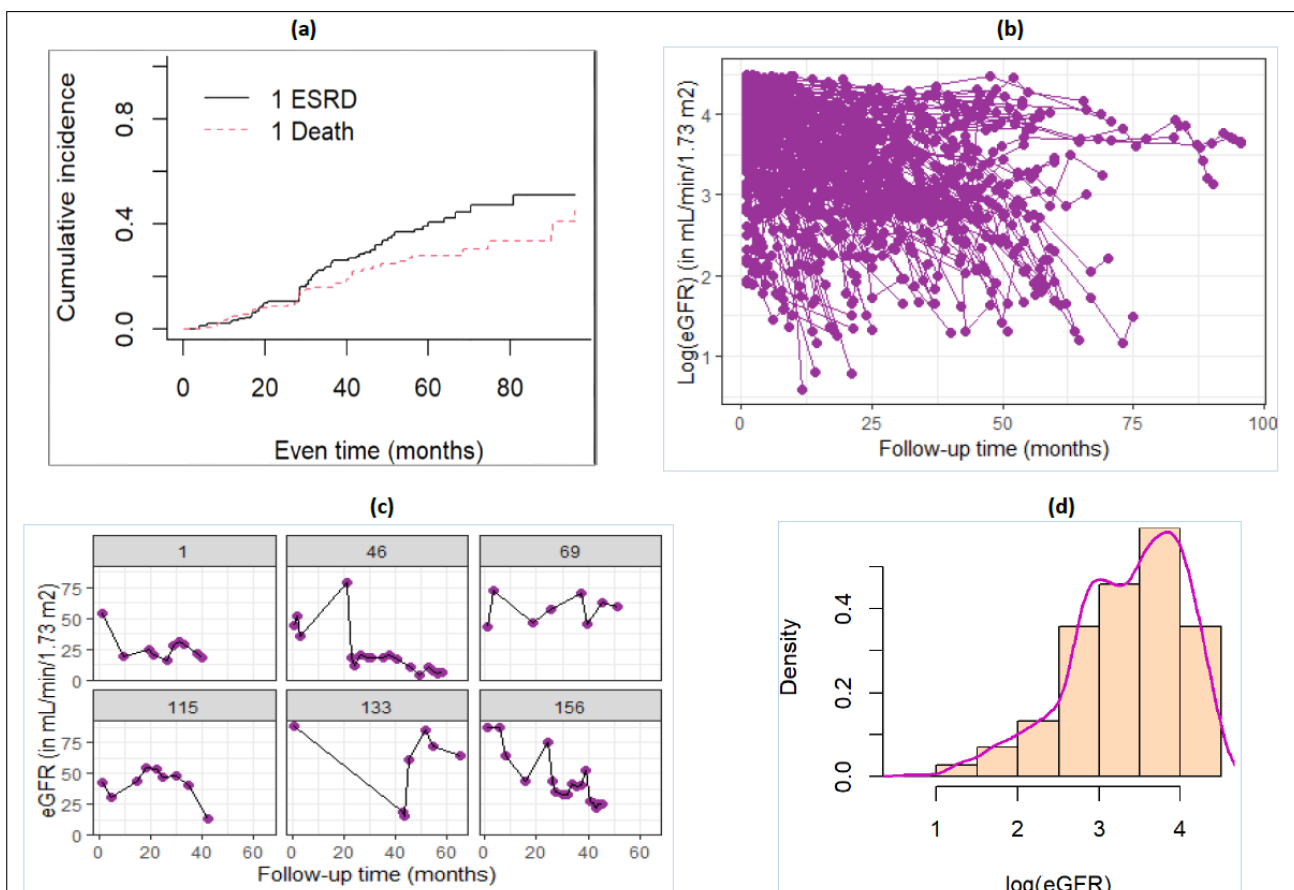
Figure 1. Plot ( a ) is the CIF for ESRD and death events, and shows an increasing probability of the occurrence of the two events as time increases; ( b ) plots the log(eGFR) trajectories against follow- up time since diagnosis of all CKD patients, where the consecutive measurements of eGFR for each patient are connected by line segments; Plot ( c ) explores more the nature of the trajectories of the longitudinal outcome eGFR using six randomly selected patients. Plot ( d ) is a histogram of log-transformed eGFR with a normal curve and shows an asymmetry (left-skewed)